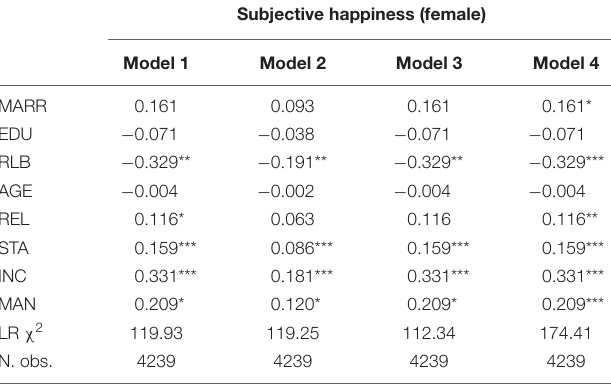
TABLE 4 | Determinants of subjective happiness (female sample).